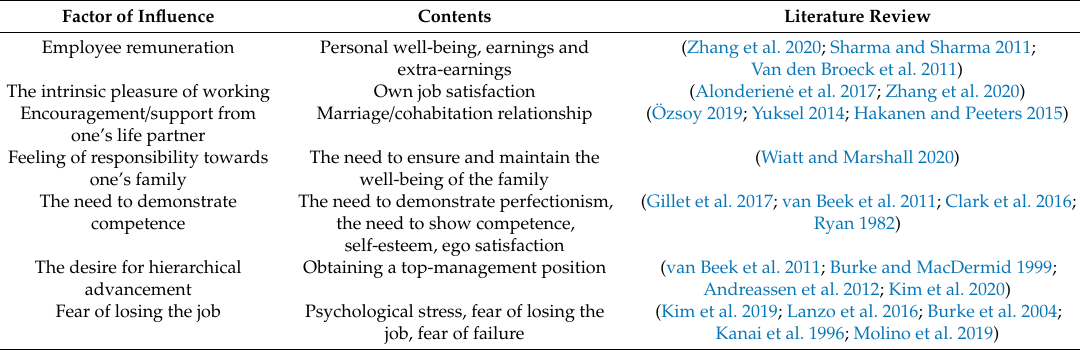
Table 1. Factors of influence for